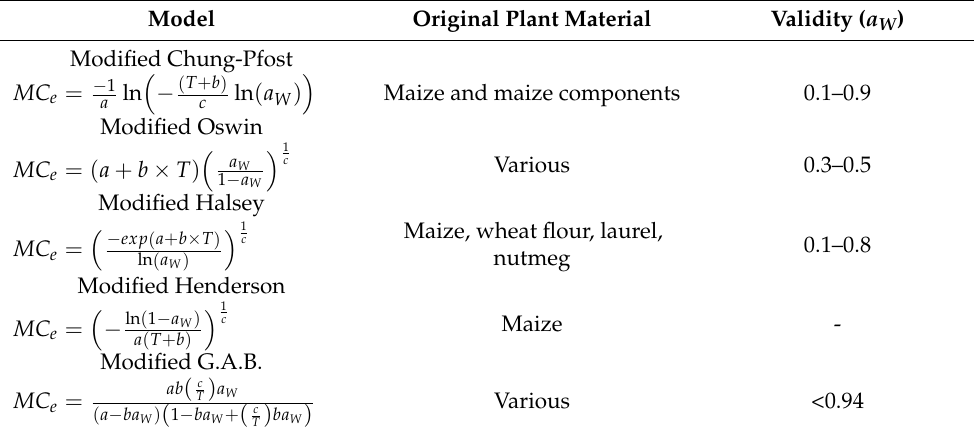
Table 1. Models for sorption isotherms. MCe = equilibrium moisture content. T = temperature in ◦ C. a w = water activity. a , b , c = model constants